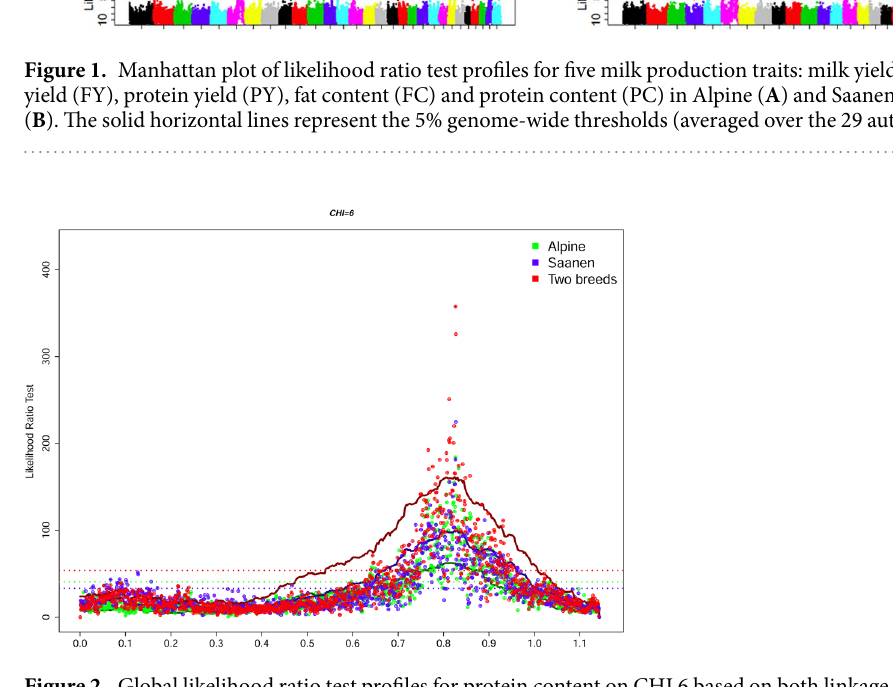
Figure 2. Global likelihood ratio test profiles for protein content on CHI 6 based on both linkage and haplotype-based linkage (solid lines) and association (dotted line) analyses. The dotted horizontal lines represent 5% genome-wide